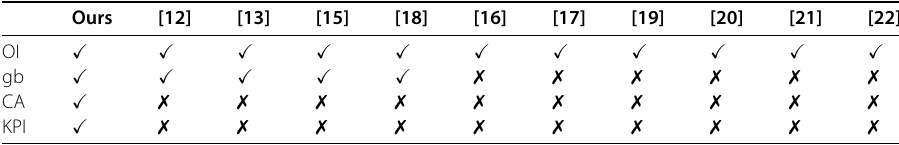
Table 1 An overview of relevant methods from the literature applied by other authors